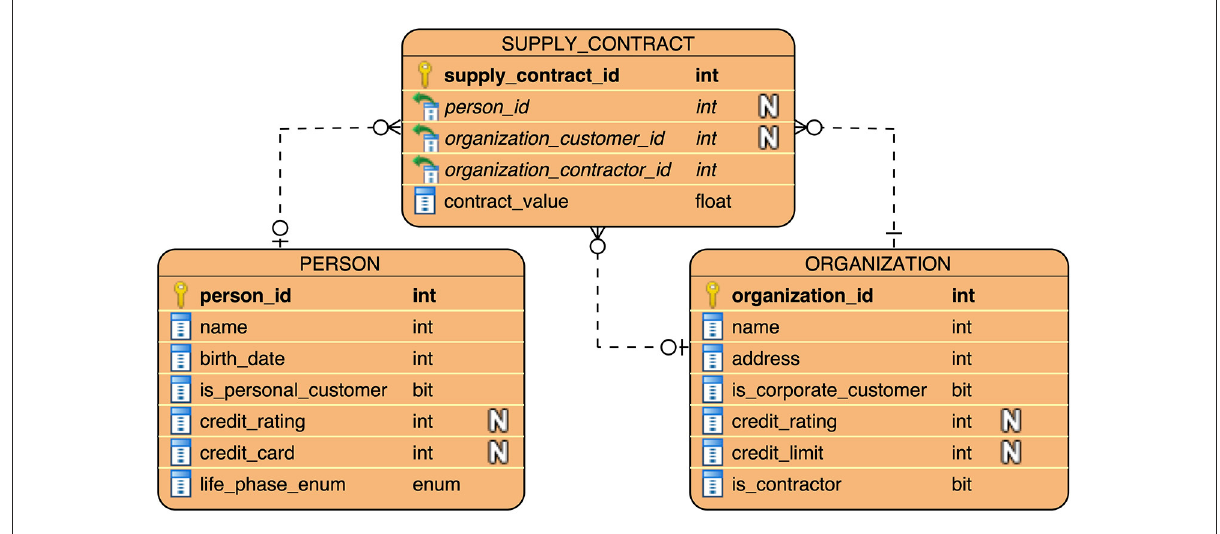
FIGURE3 Target schema with the one table per kind